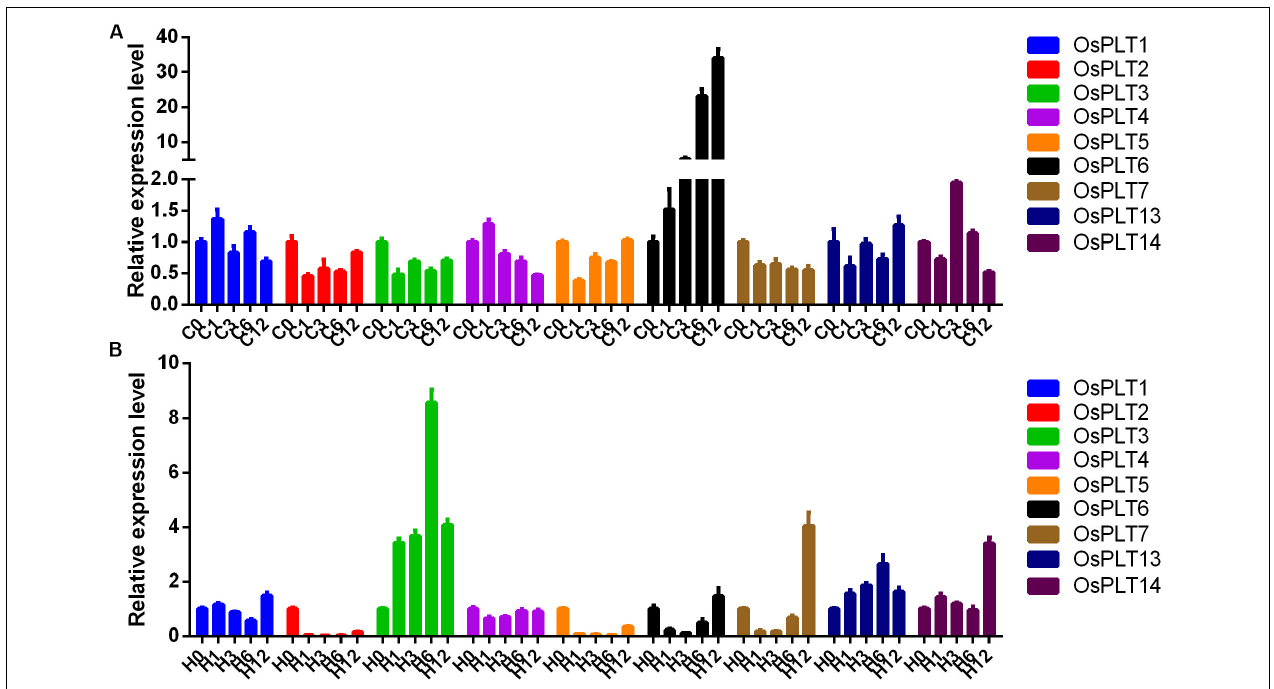
FIGURE 9 | Expression changes of rice PLT genes under cold (A) and heat (B) stresses by qRT-PCR. The numbers 0, 1, 3, 6, and 12 represent 0, 1, 3, 6, and 12 h after treatments.